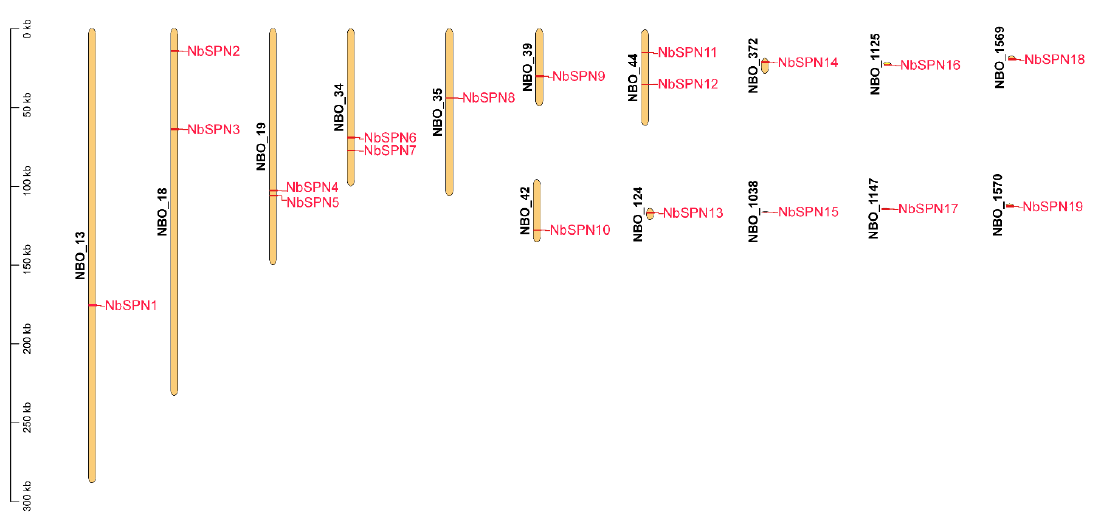
Figure 5. Genomic distribution of NbSPN genes across the fifteen N. bombycis scaffolds. The scaffold count is shown on the left side of each scaffold. The scale is in kilobase (Kb). The scaffold locations of the NbSPNs were determined according to the physical location of each gene.